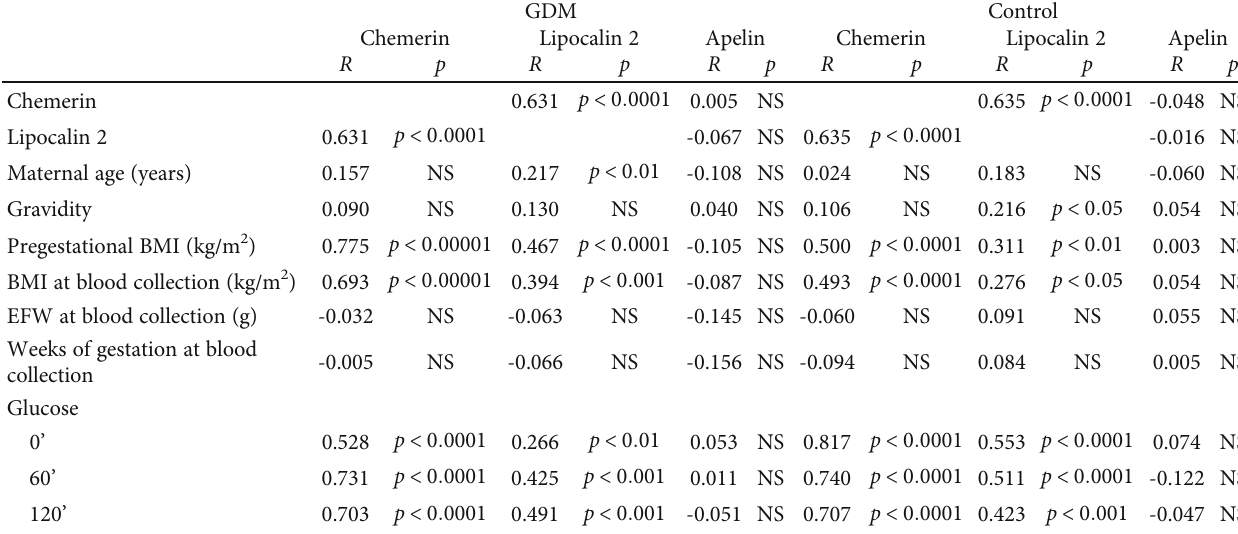
Table 3: Correlation between chemerin, lipocalin, apelin levels, maternal age, gravidity, BMI, EFW, gestational age, and glucose concentrations in OGTT in GDM patients and control